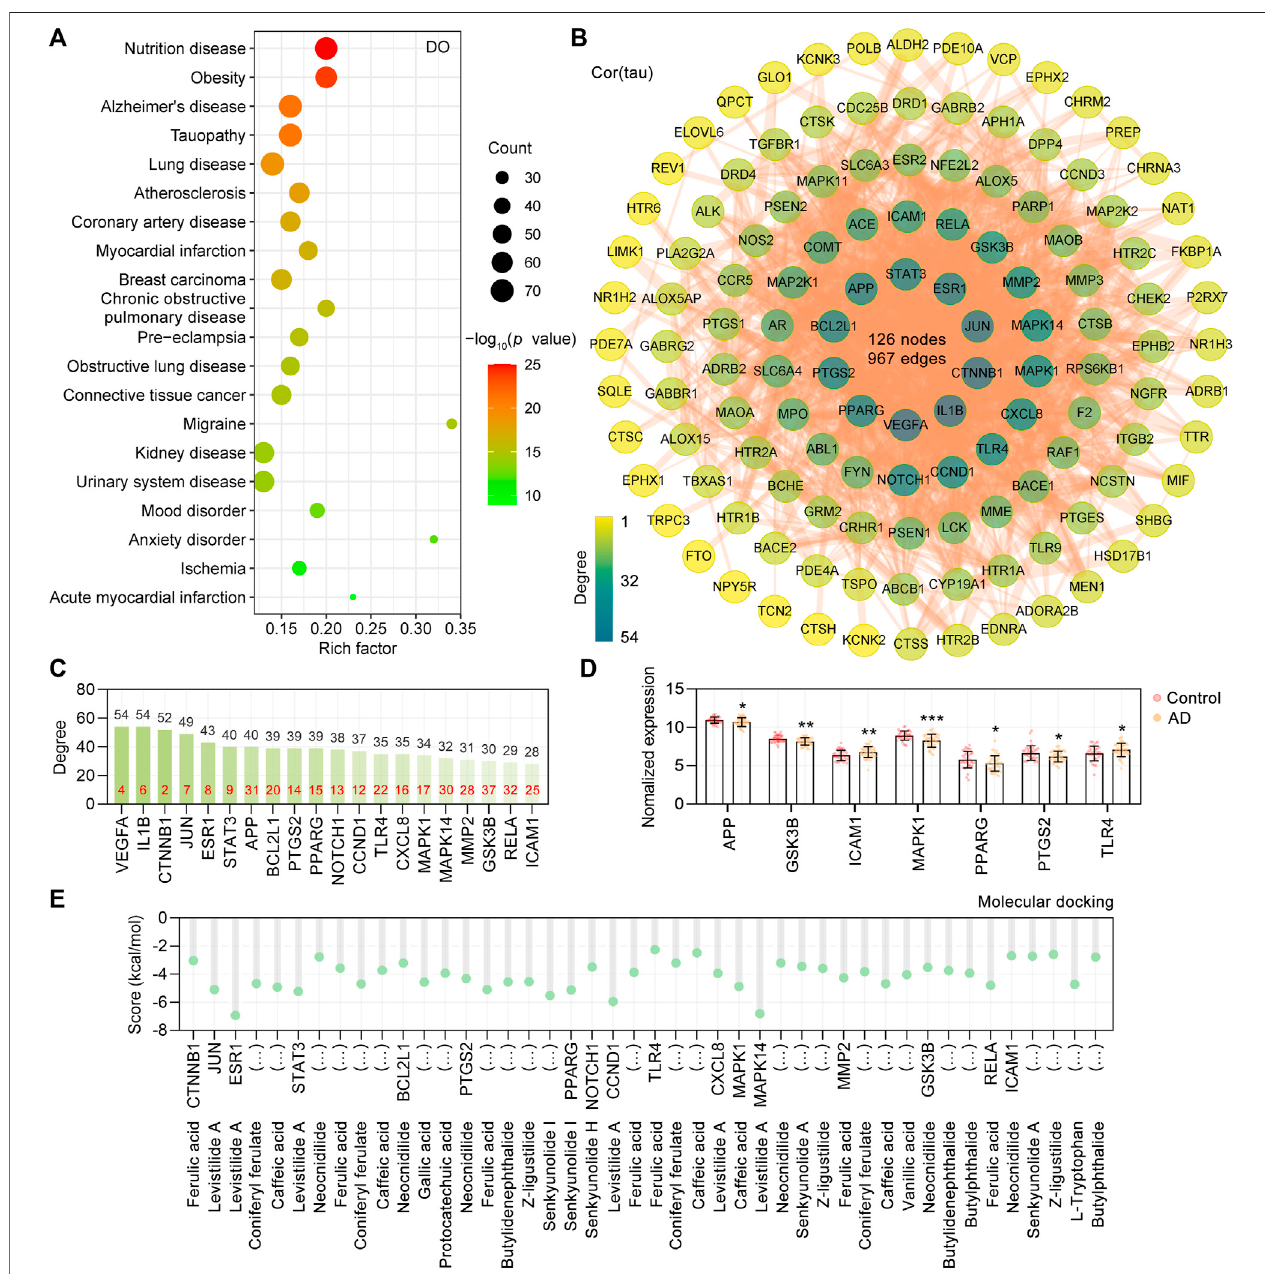
FIGURE 2 | PPI network of CR targets associated with tau pathogenesis. (A) Top 20 signi fi cantly enriched Disease Ontology (DO) terms are shown as a bubble diagram.DOtermswithcorrected p value < 0.05wereconsideredsigni fi cantlyenriched.Thex-axis,richfactor(theratiooftargetsinthebackgroundterms).Bubblesize, the number of genes enriched. Bubble color, p value. (B) 127 targets related to tau pathogenesis were utilized to construct the PPI network. The color of the node correlates with its degree value. (C) The top 20 targets ranked by degree value were identi fi ed as the core targets. The red numbers in the bar chart represent the degree value ranking of the core targets in the CR ’ s 376 target PPI network. (D) Differentially expressed core targets of CR related to tau pathogenesis in the temporal cortex of the control ( n = 39) and AD group ( n = 52). Data are plotted as individual data points overlaid with mean ± SD. * p < 0.05, ** p < 0.01, *** p < 0.001. (E) Docking score (kcal/mol) of CR phytochemicals with their corresponding core